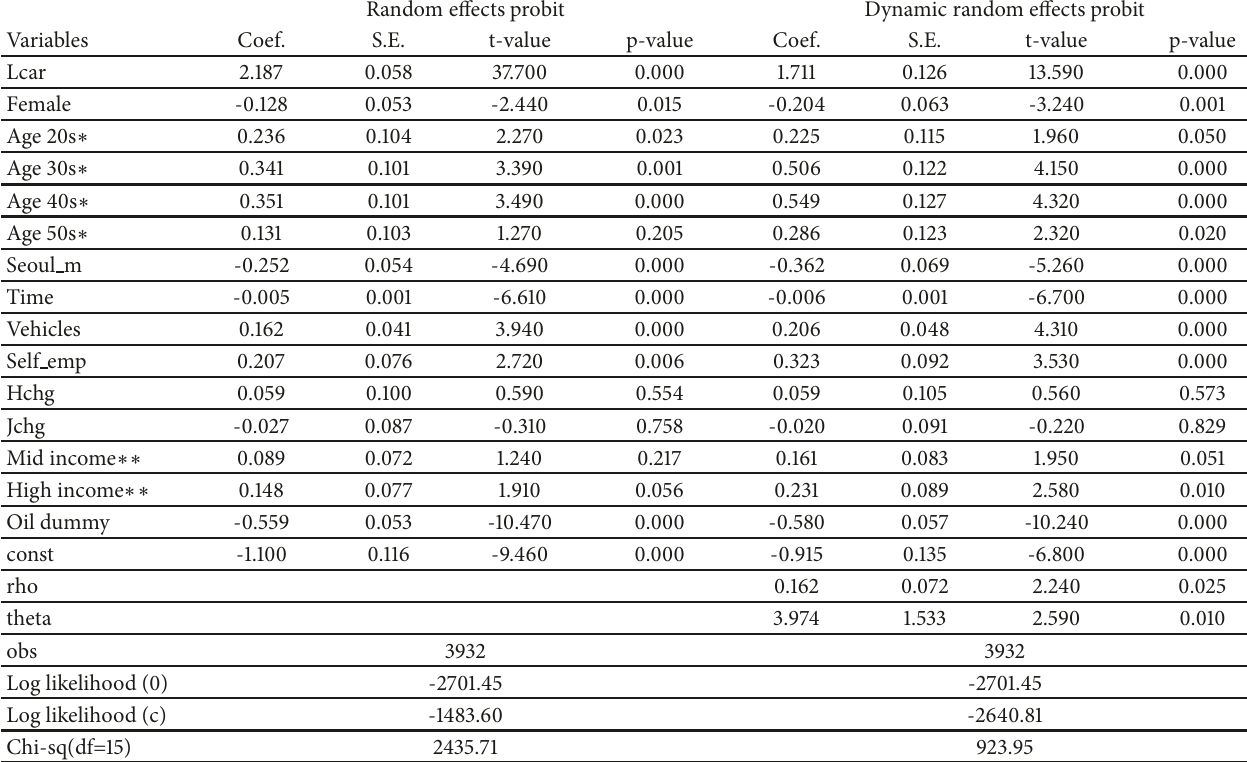
Table 6: Probit results of passenger car